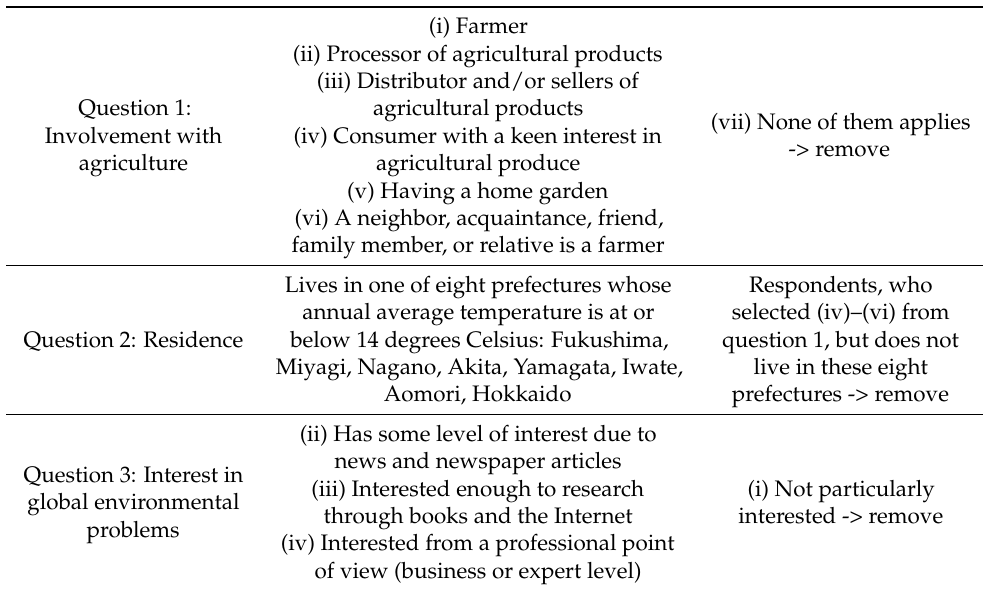
Table 1. Screening items and